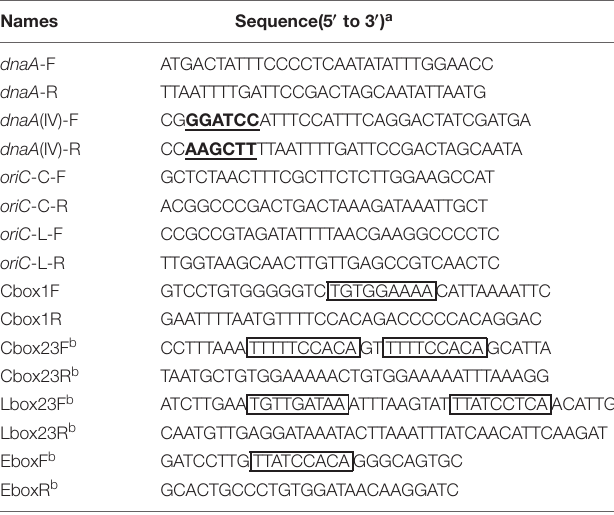
Frontiers in Microbiology |